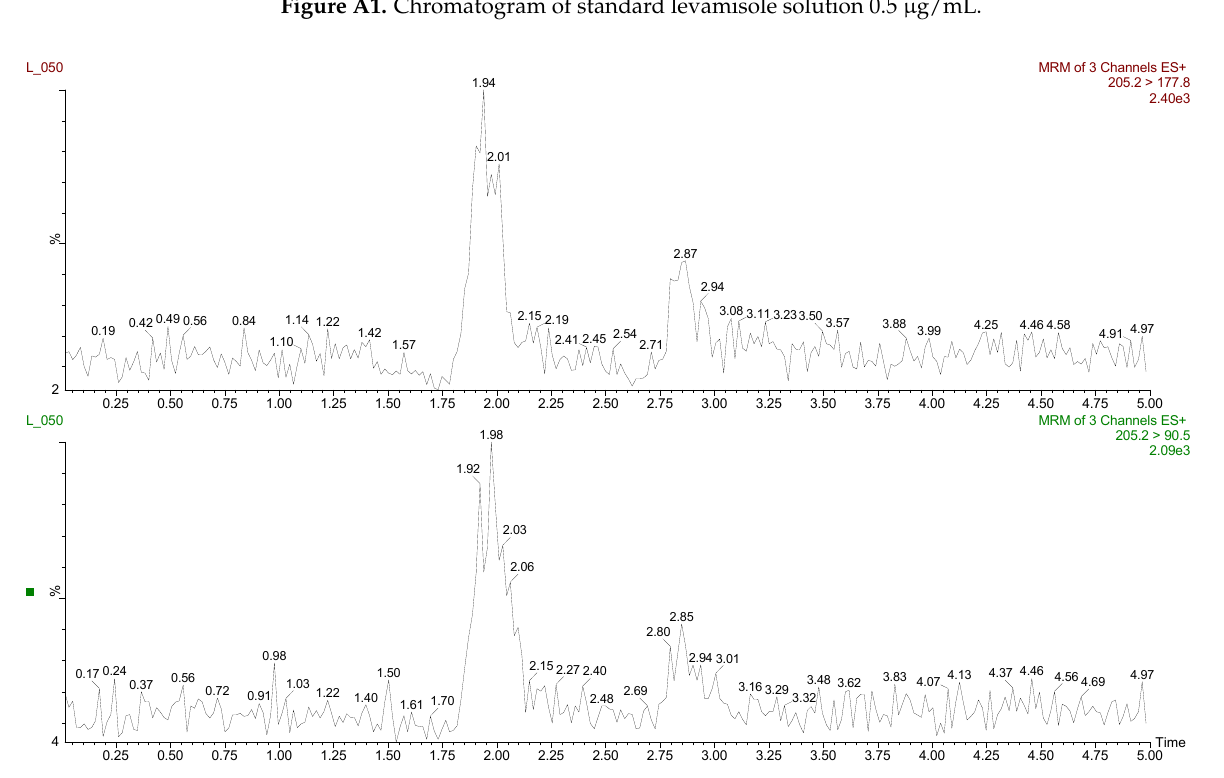
Figure A2. Chromatogram of the liver control sample.